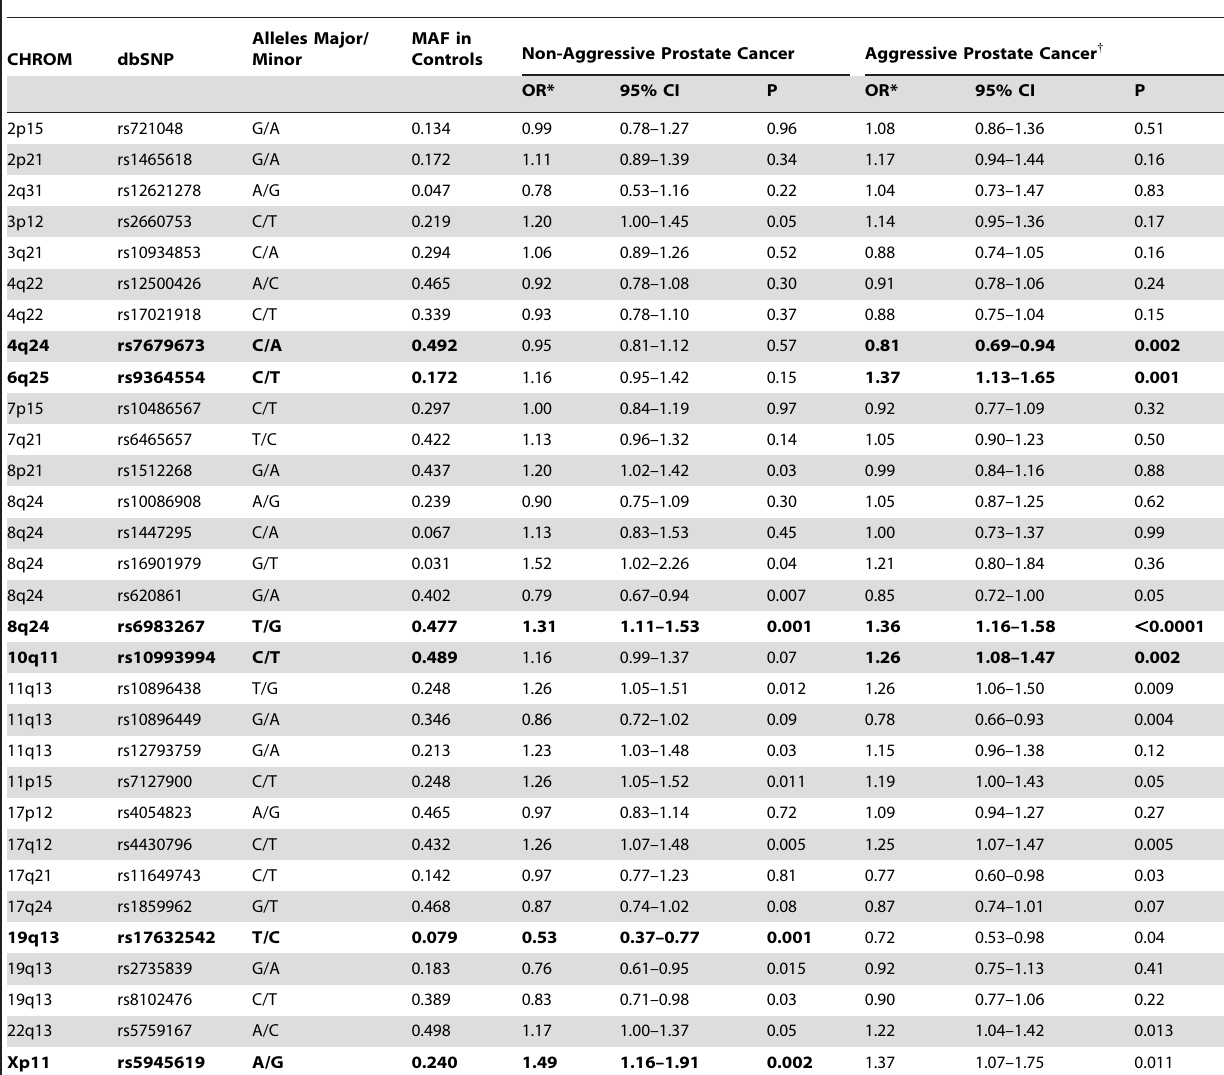
Table 2. Associations of GWAS SNPs with Clinical Characteristics of Prostate